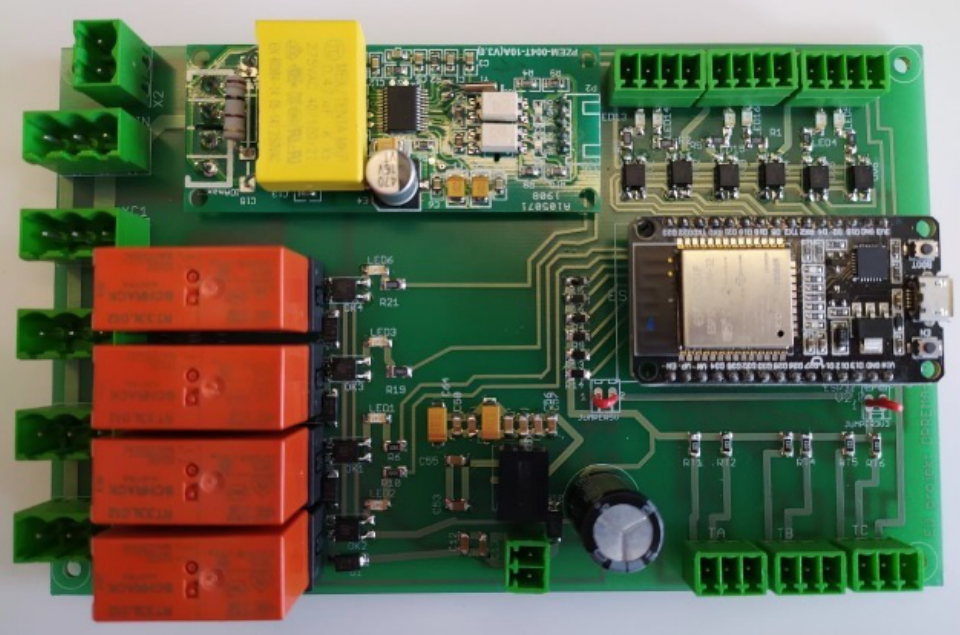
Figure 7. New motherboard with relay switching